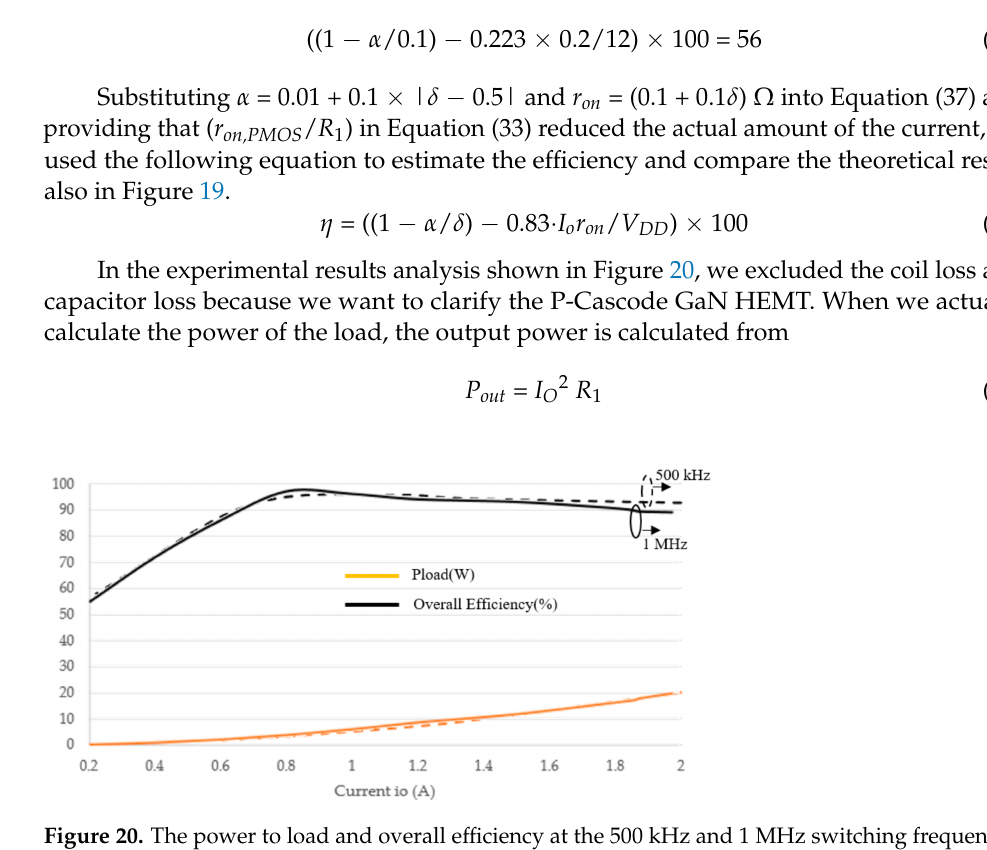
Figure 20. The power to load and overall efficiency at the 500 kHz and 1 MHz switching frequencies vs. the different output currents via duty